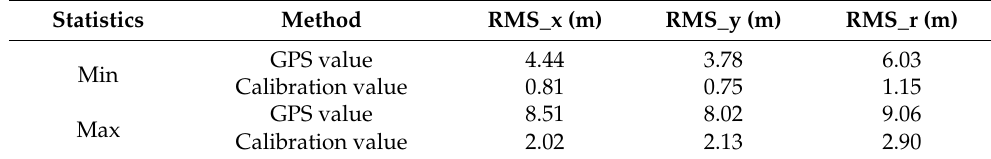
Table 1. The RMS analysis results of buoy